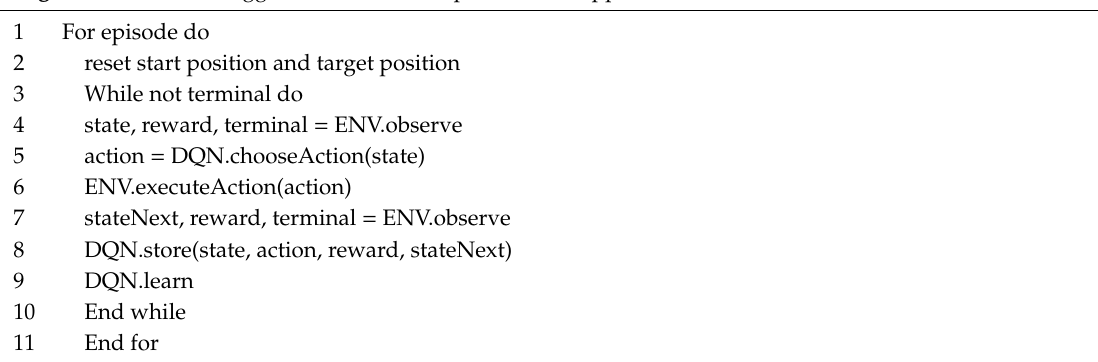
Algorithm 1. Event-Triggered Distributed Optimization